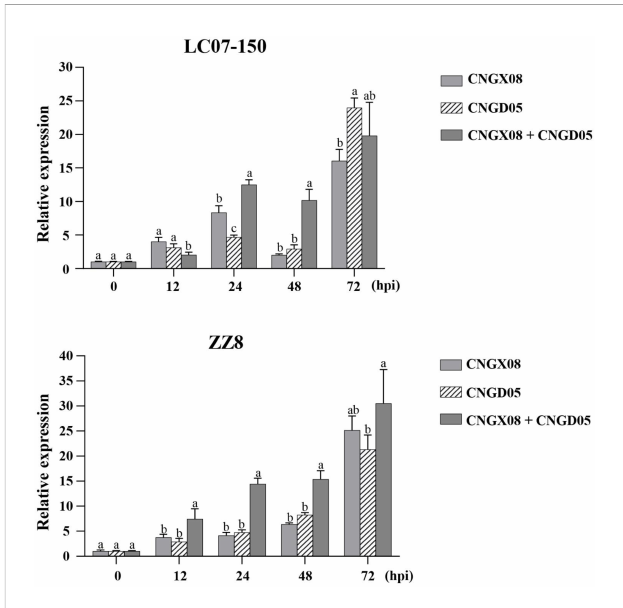
FIGURE 5 Relative expression of pathogenesis-related protein 1 (PR-1) gene in two sugarcane varieties (LC07-150 and ZZ8) inoculated with strains CNGX08 and CNGD05 of Acidovorax avenae subsp. avenae ( Aaa ). Inoculated leaf samples were collected 0, 12, 24, 48, and 72 hours post inoculation (hpi). Each vertical bar represents the mean ± standard deviation of three biological and three technical replicates per subsample. At each time point, means with the same letter are not signi fi cantly different at P = 0.05 according to Duncan ’ s